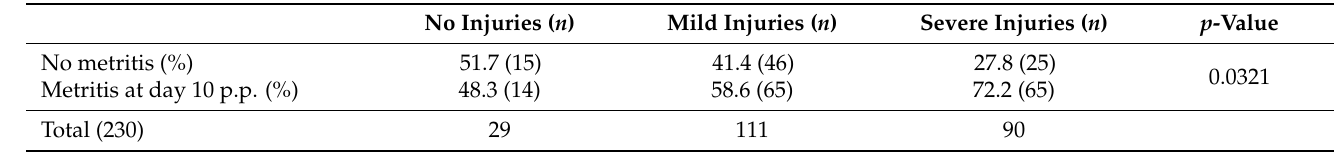
Table 4. Association between injuries of the soft birth canal (no injuries, mild injuries: maximum injuries of degree 1, severe injuries: injuries of degree 2, or combinations of no injuries or injuries of degree 1 with injuries of degree 2) and the occurrence of metritis at day 10 p.p. No Injuries ( n ) Mild Injuries ( n ) Severe Injuries ( n ) p -Value